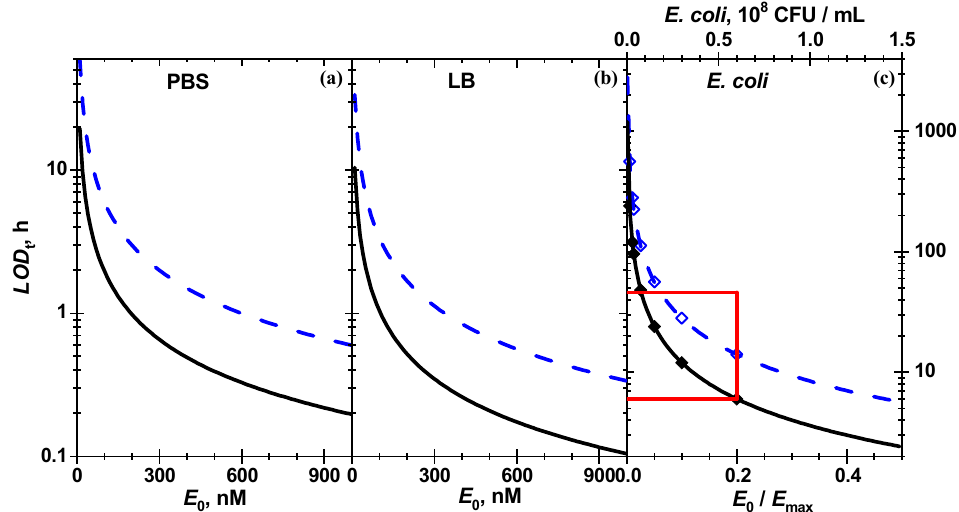
Figure 8. The concentration dependence of LOD t for the enzymatic cleavage of chitosan-g-X-Gluc by ( a , b ) β -Gus solutions and ( c ) E. coli Mach1 triggered enzymatic hydrolysis in bacterial suspension for the data included in the global fit (solid black) and for all data (dashed blue). ( c ) The bacterial concentration in the dispersions is shown on the top axis. The minimal reaction times for the dilution used in the experiment are shown with diamonds. The red rectangle limits the area of the E. coli Mach1 detection studied in the present